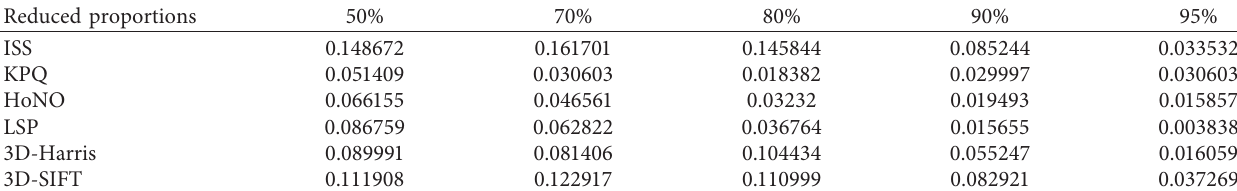
of the key point detection algorithm on the random view data set. density